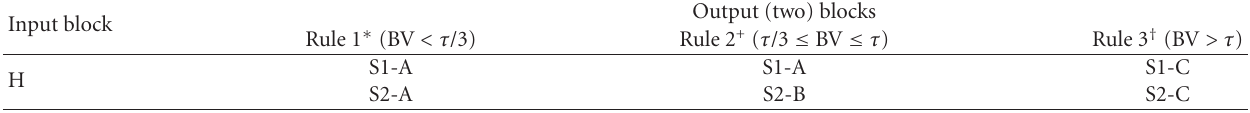
Table 1: Three rules of data embedment for each host